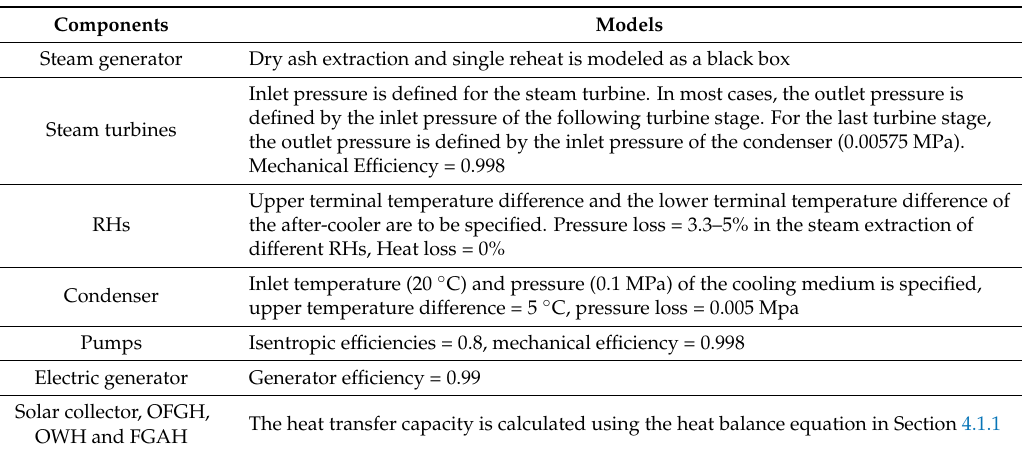
Table 4. Models details of the primary components in EBSILON Professional.